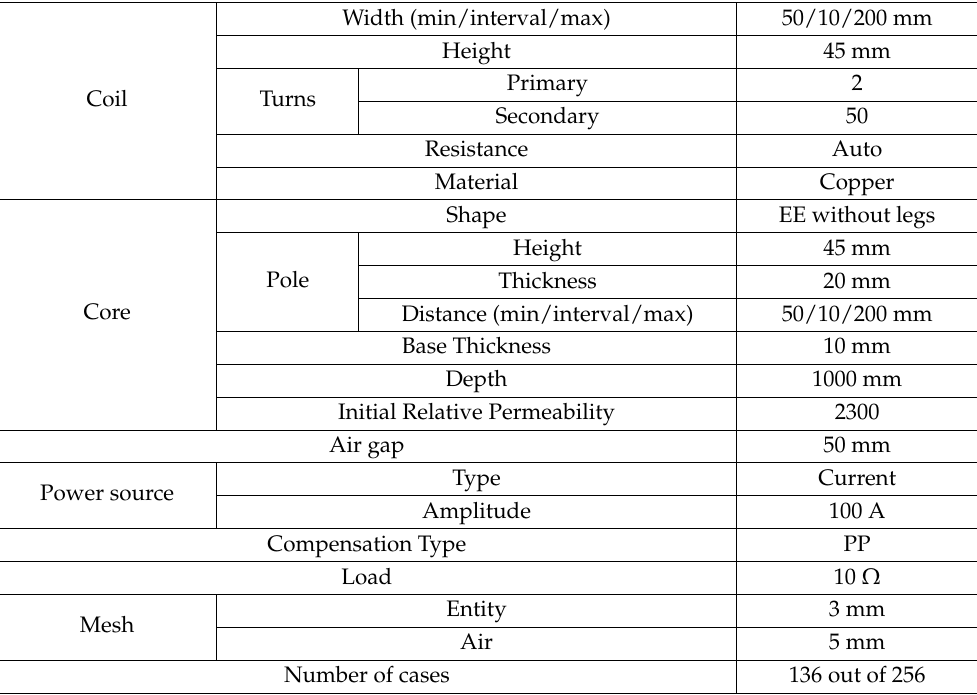
Table 2. The setting of grid analysis mode